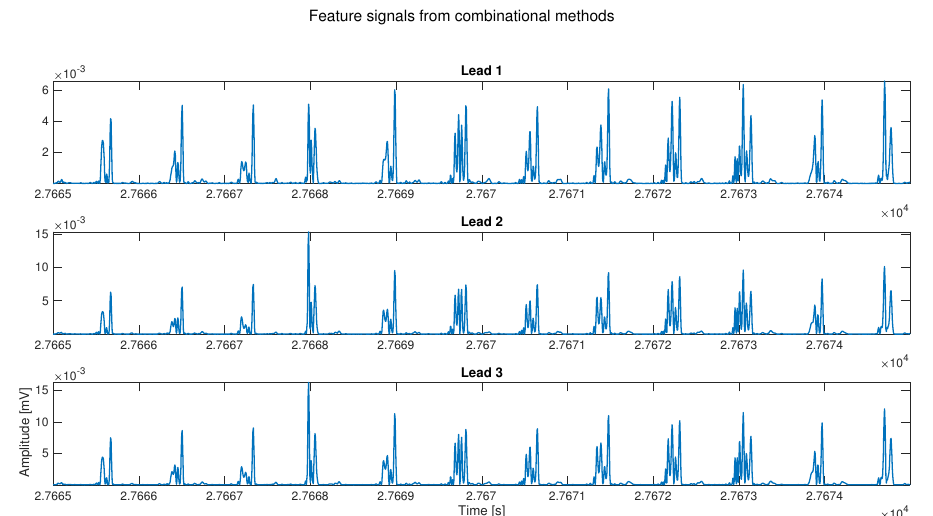
Figure 3. Computed feature signals for each proposed method. The upper four panels show the feature signal for the next methods: ICA, PCA, PT, and RMS. In the lower panel, the feature signals from the combinational methods are